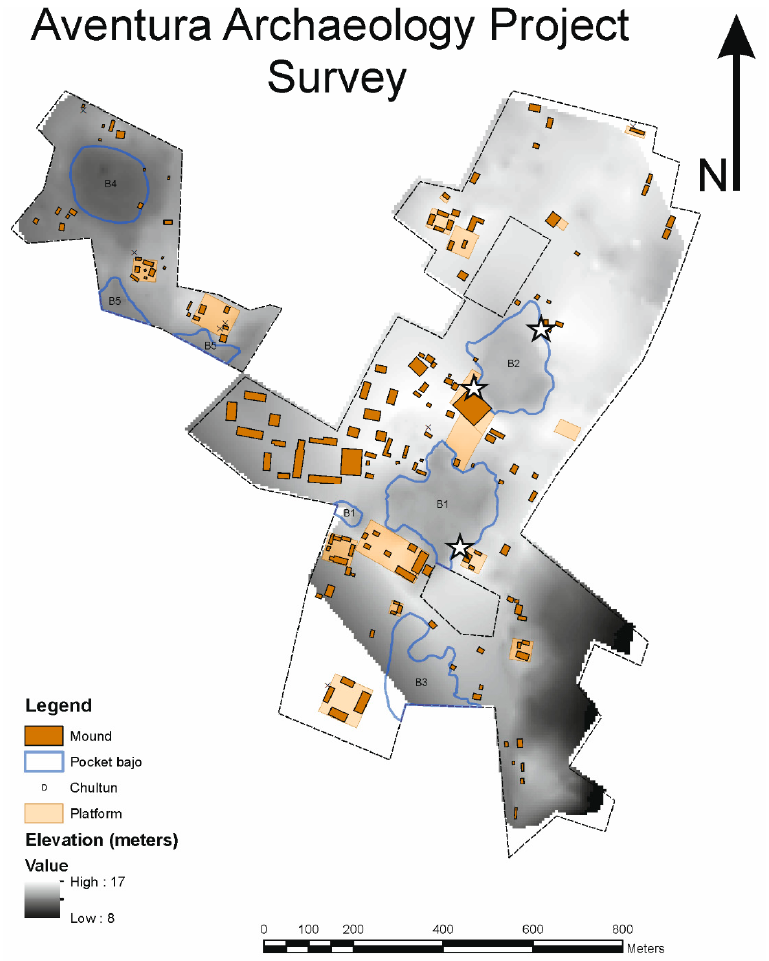
Figure 2. Map of the central core of Aventura (Belize) showing the close-knit relationship between significant building groups and integrated pocket bajos containing soil resources, always keeping some of their edges clear from built development. Stars indicate excavation locations (source: [45] (p: 83) reprinted with permission from Kacey C.